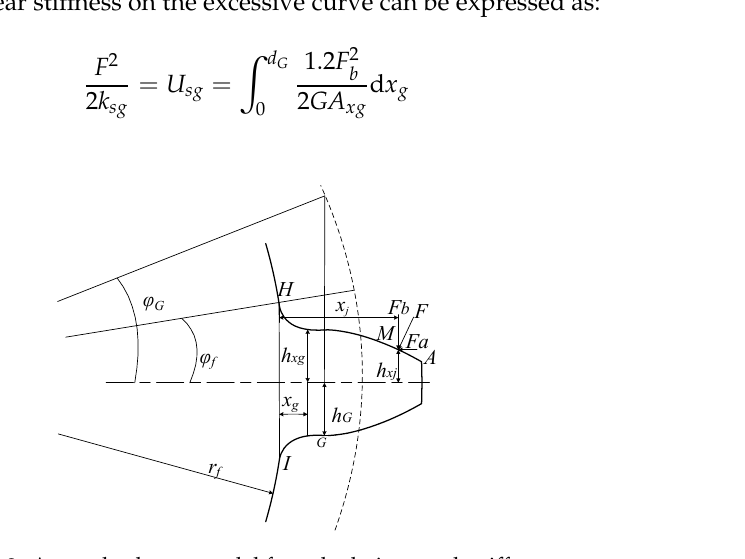
Figure 2. A standard gear model for calculating mesh stiffness. Table 2. Parameters for the transition part of the curve.